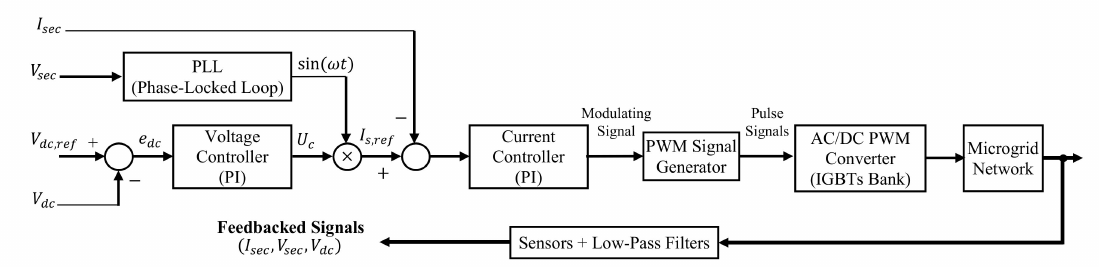
Figure 5. Baseline control loop of the AC / DC pulse-width modulation (PWM) converter based on proportional-integral (PI) control.